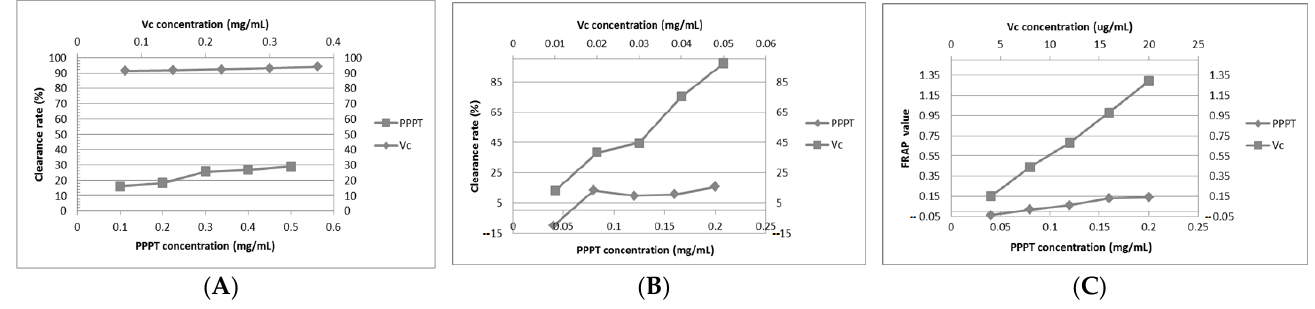
Figure 2. Antioxidant activities of PPPT: DPPH radical scavenging activity ( A ); HO scavenging activity ( B ); total antioxidant activity ( C ).